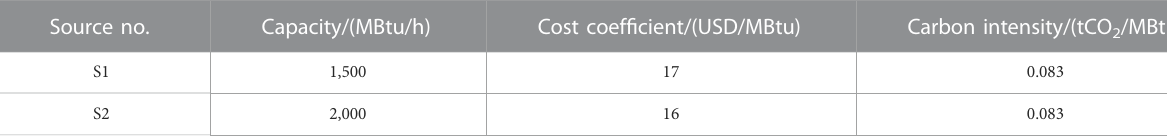
TABLE 2 Natural gas source parameters. Source no.